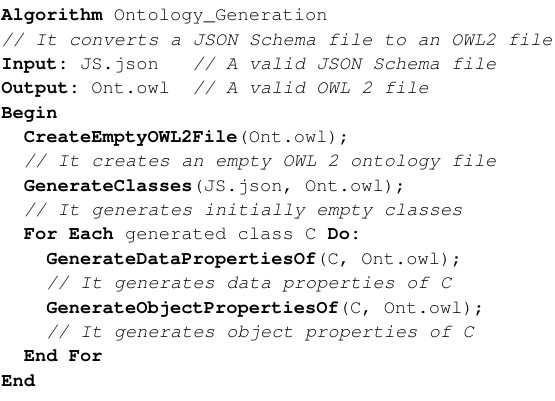
Fig. 2 Algorithm of the “Ontology Generation” module.